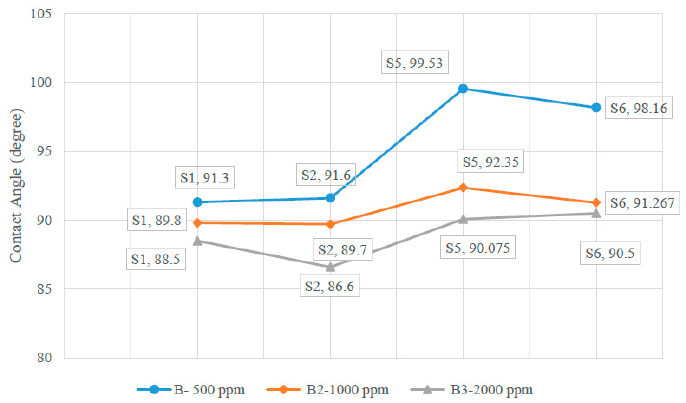
Figure 7. Variation in contact angle of samples containing kaolinite clay with each brine.